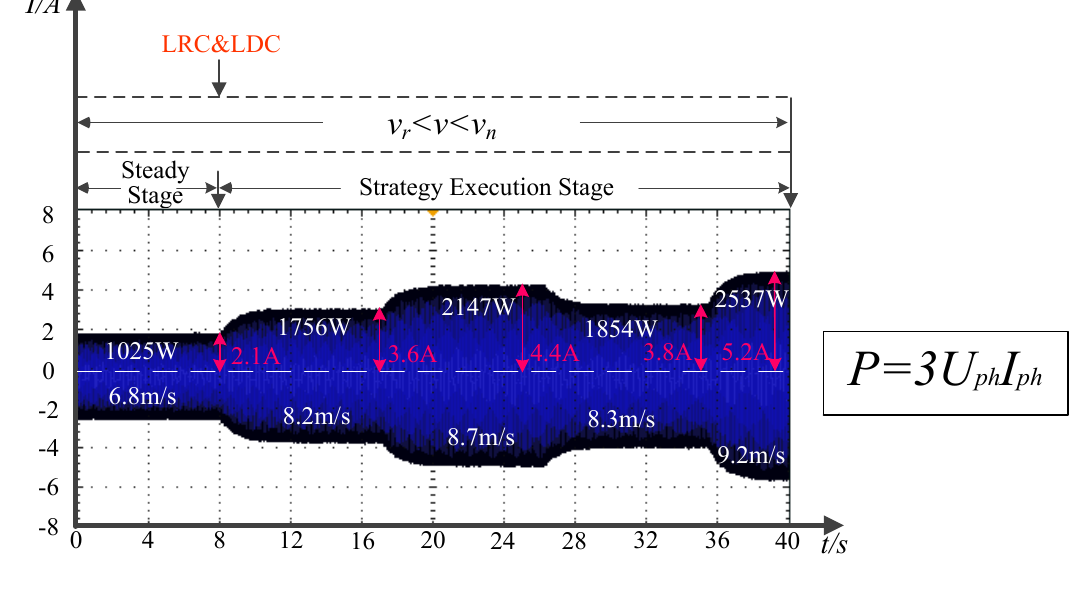
Figure 11. Generation of WTSS in Scenario